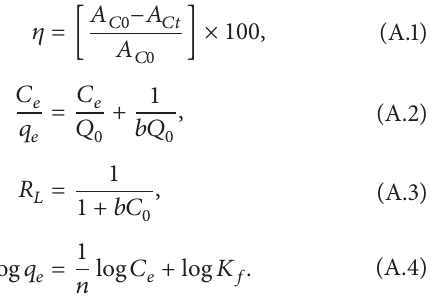
a beneficial adsorption. However, the dimensionless constant ( 𝑅 𝐿 = 0.148) falls within the favorable limit in